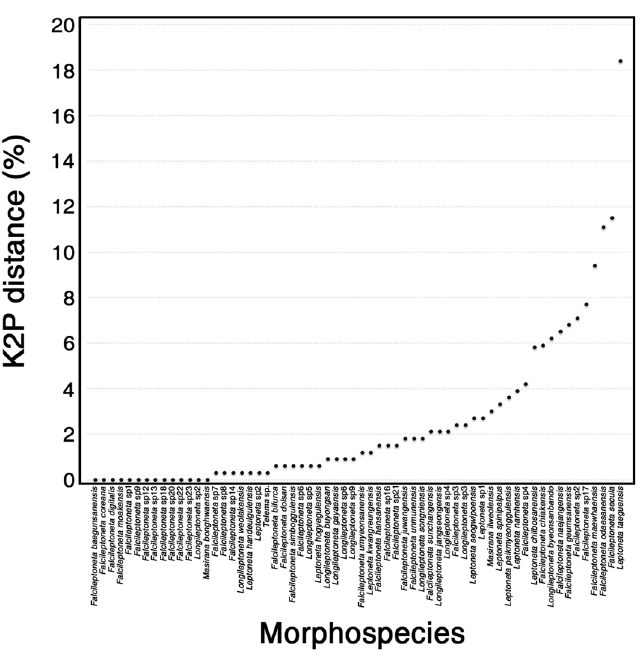
Figure 3. Maximum intraspecific divergences (%) based on Kimura 2-parameter model from the dataset. Morphospecies having a single specimen are not